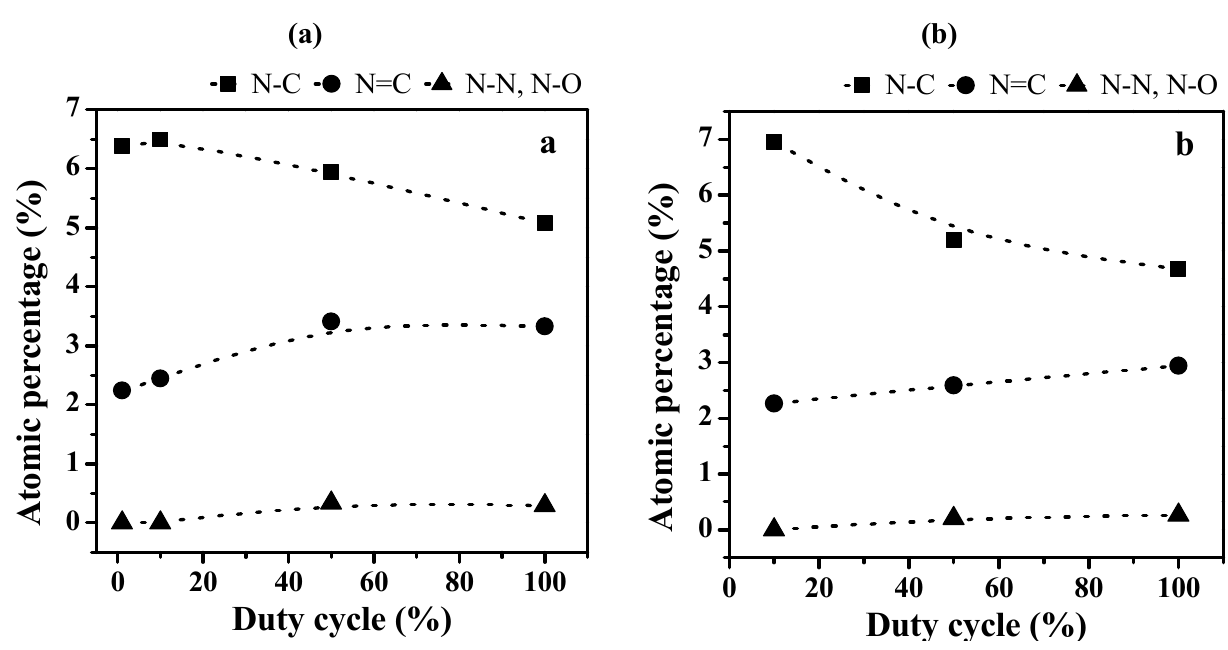
Figure 7. Evolution of the bonds proportion for the N non-quaternized films (analyzed with the SIA 200 instrument) as a function of the duty cycle ( DC ) for plasma polymers prepared at ( a ) 40 W and ( b ) 150